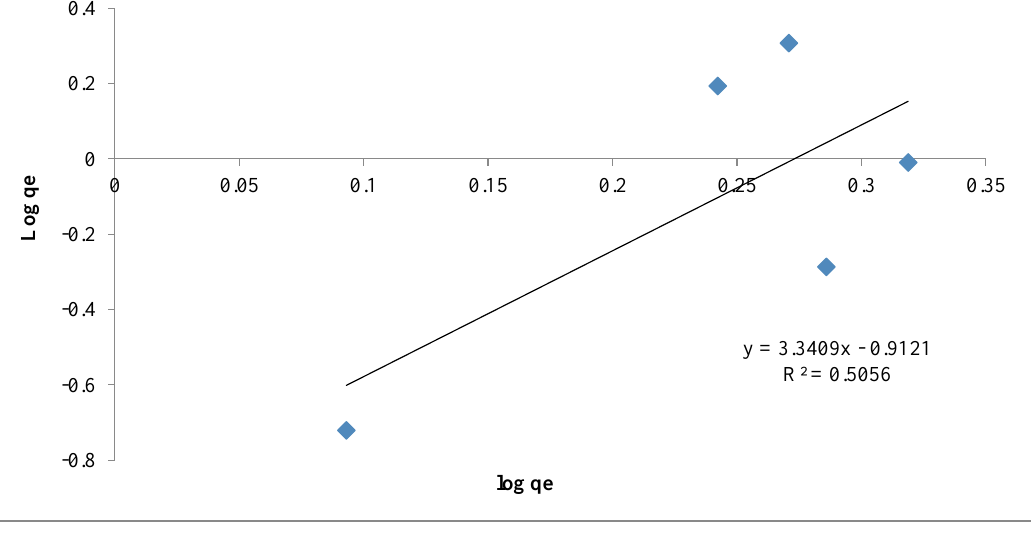
Figure 5. Freundlich isotherm for sawdust